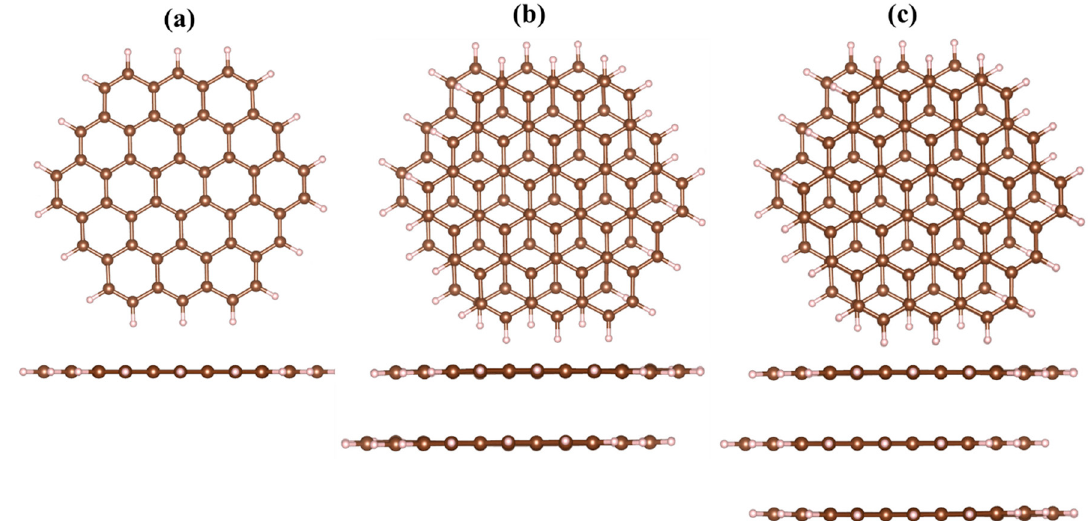
Figure 1. Optimized structures of zigzag-edged graphene quantum dots (GQDs) (top view and side view): ( a ) Monolayer, ( b ) bilayer, and ( c ) trilayer. Small balls correspond to hydrogen atoms; large atoms represent carbon species belonging to the GQDs.